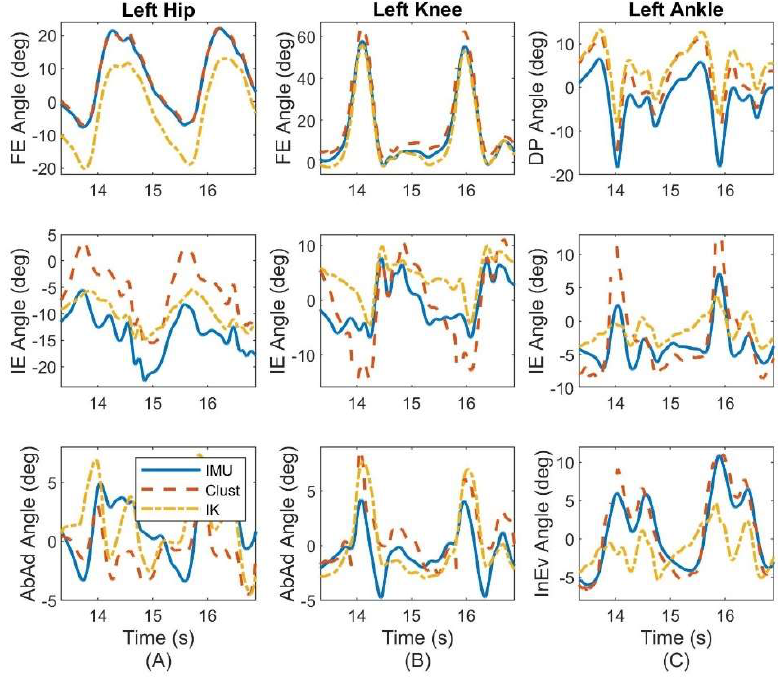
Figure A3. Slow Walking. Example joint angle estimates over two stride cycles for slow treadmill walking. Plots show the three anatomical angles for ( A ) left hip, ( B ) left knee, and ( C ) left ankle. Estimates are also compared between ErKF (IMU), cluster (Clust), and inverse kinematics (IK) methods.